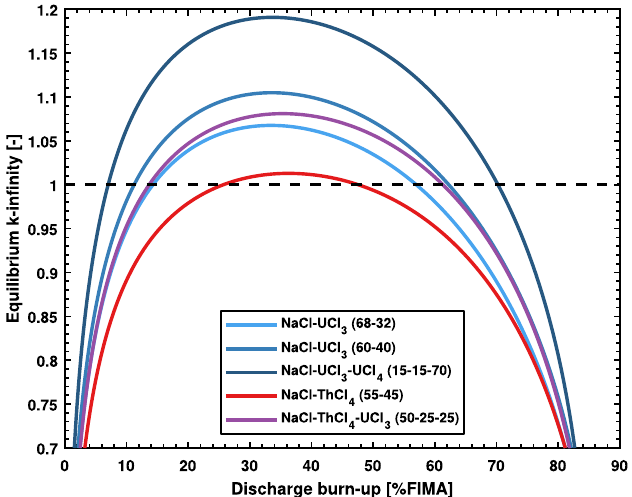
Fig. 8. Evaluation of the k ∞ at equilibrium of chloride salts in a fast spectrum using the neutron excess